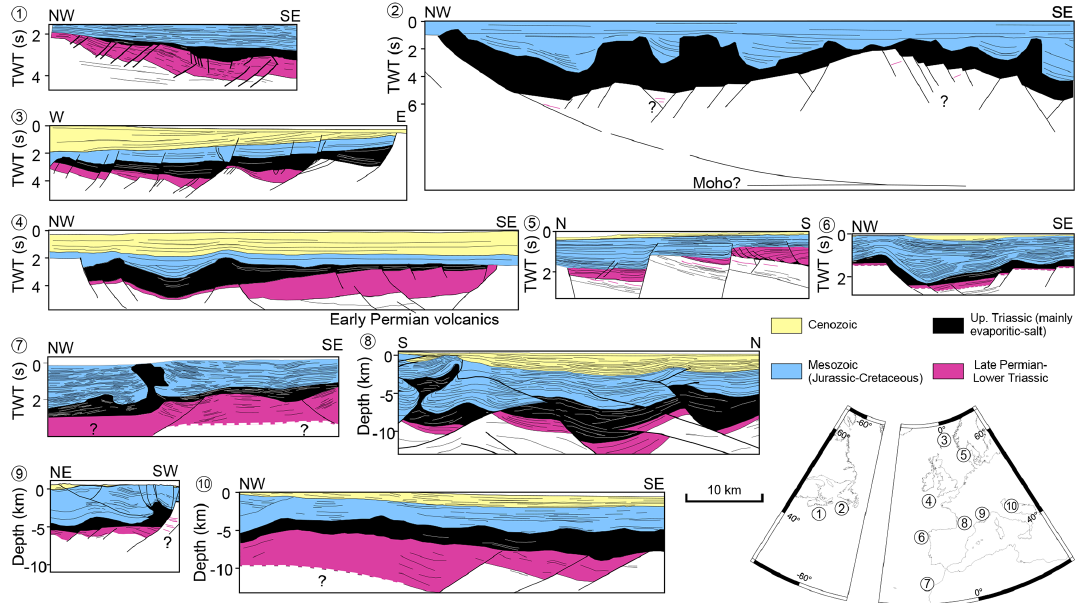
Figure 2. Compilation of interpreted seismic profiles along the North Atlantic margins and in western Europe. (1) Deptuck and Kendell (2017); (2) Balkwill and Legall (1989); (3)–(4) McKie (2017); (5) Philipps et al. (2019); (6) Rasmussen et al. (1998); (7) Hafid (2000); (8) Espurt et al. (2019); (9) Bestani et al. (2016); (10) Scisciani and Esestime